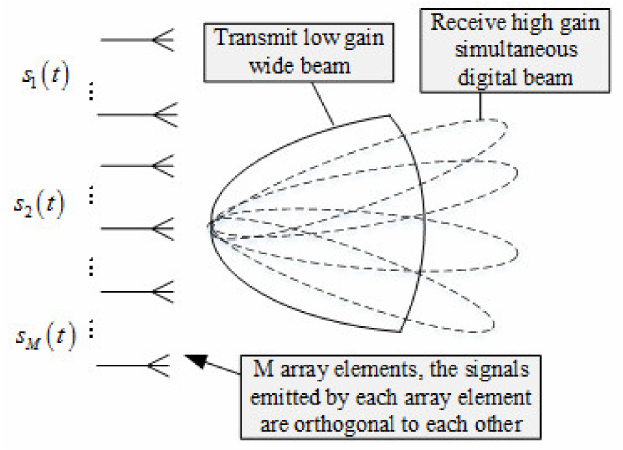
Figure 1. Basic principles diagram of MIMO radar.